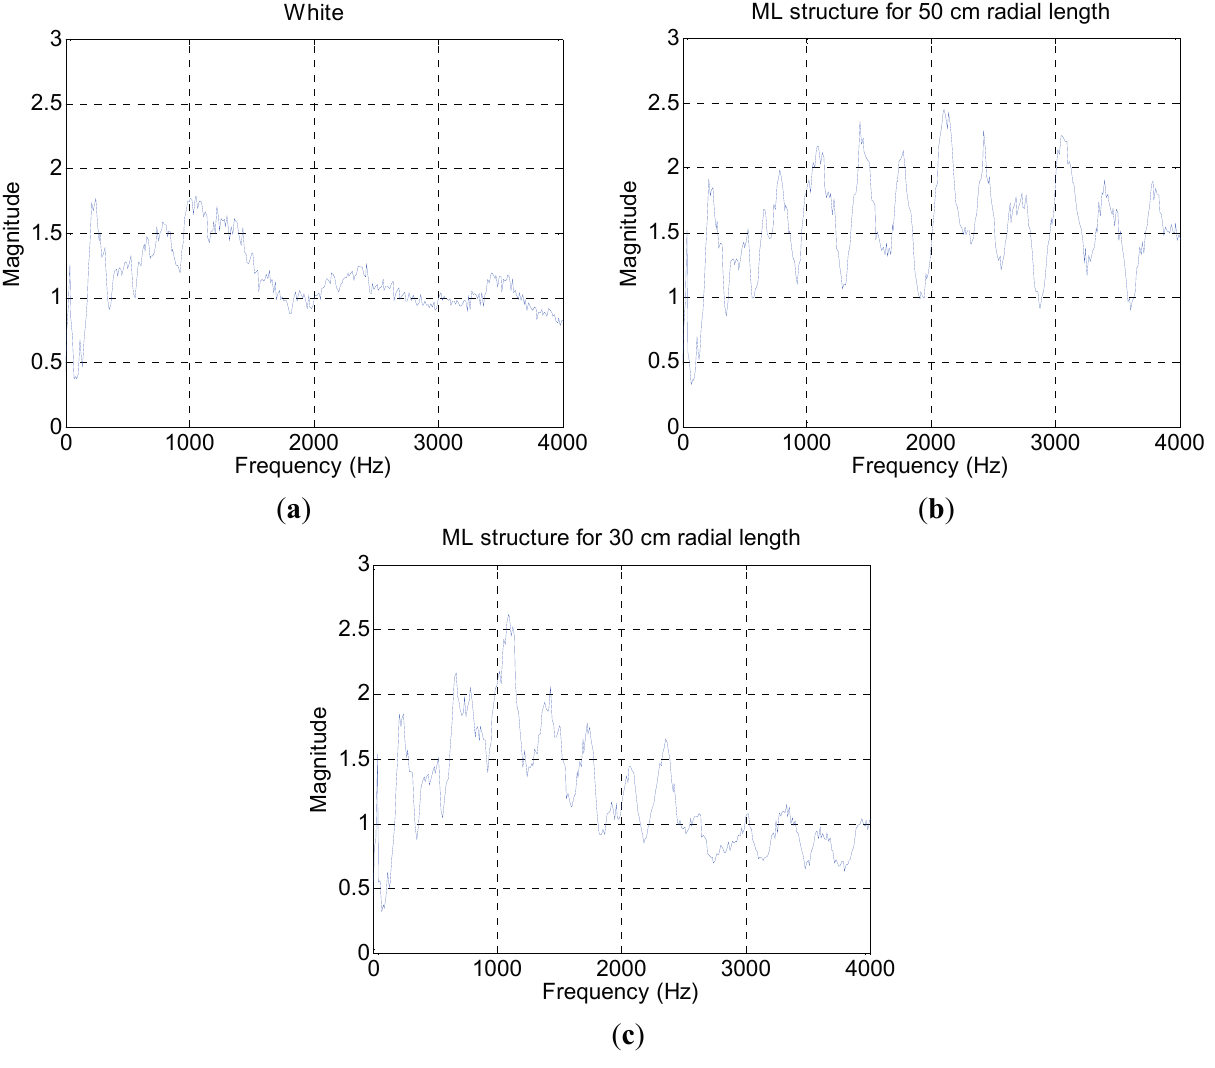
Figure 9. Frequency response of ( a ) anechoic chamber; ( b ) ML structure for 50 cm length; and ( c ) ML structure for 30 cm